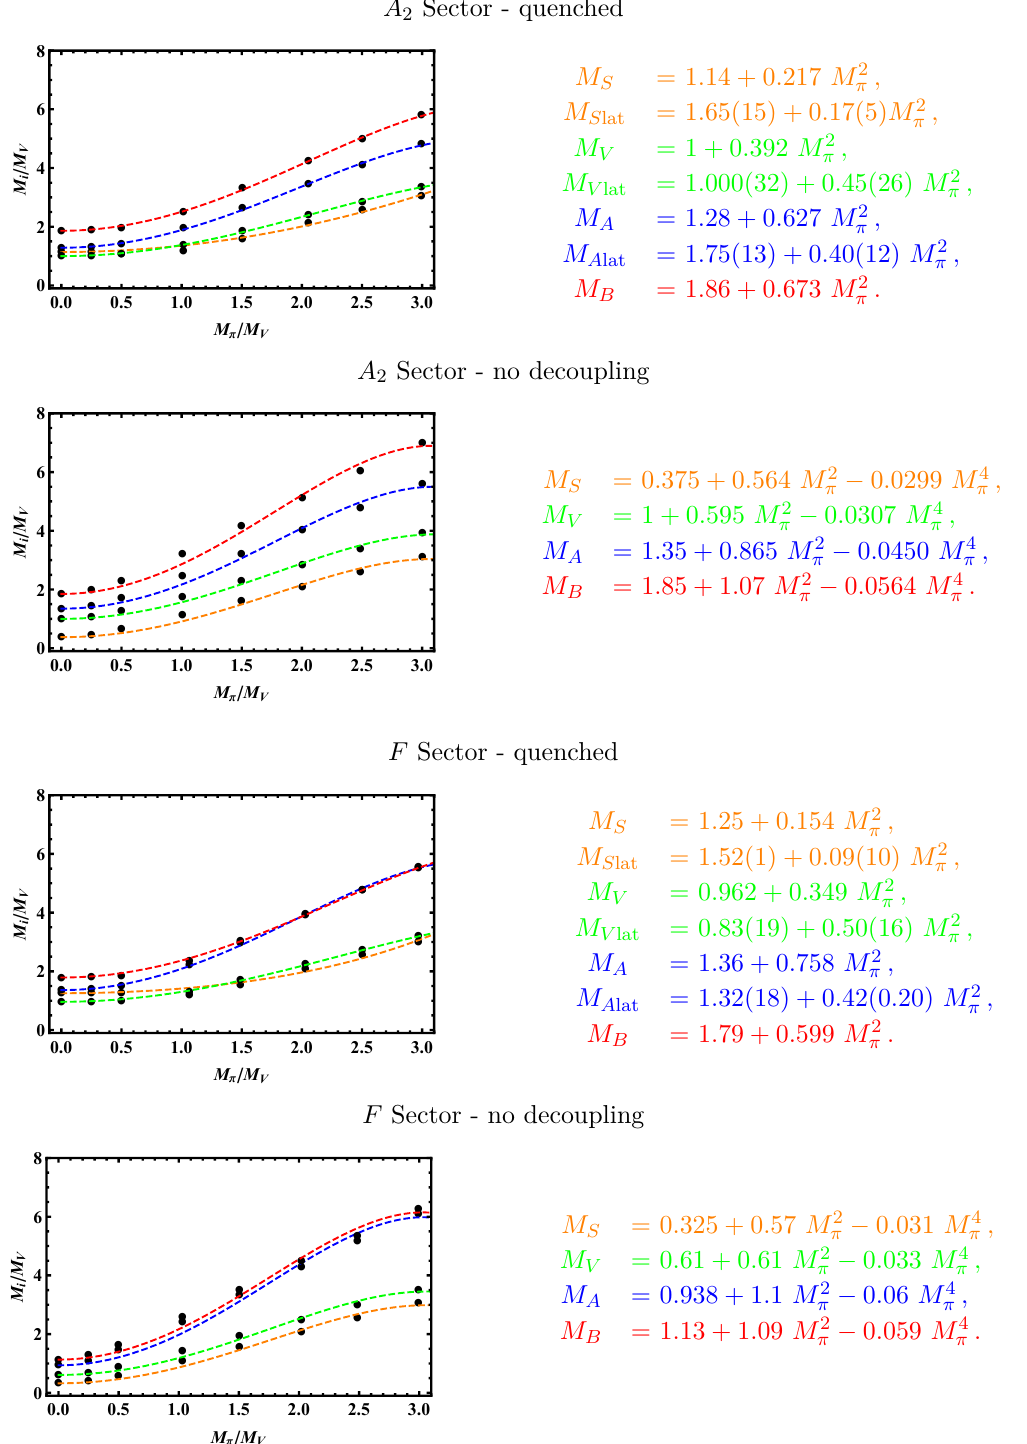
Figure 12. AdS/ Sp(4) 4 F, 6 A 2 — results for the spectrum as a function of the pNGB mass in the quenched theory and the case with no decoupling of the A 2 — lattice results from [79] are included for comparison. In our analytic formulae we use units of the vector meson mass at m q | UV = 0